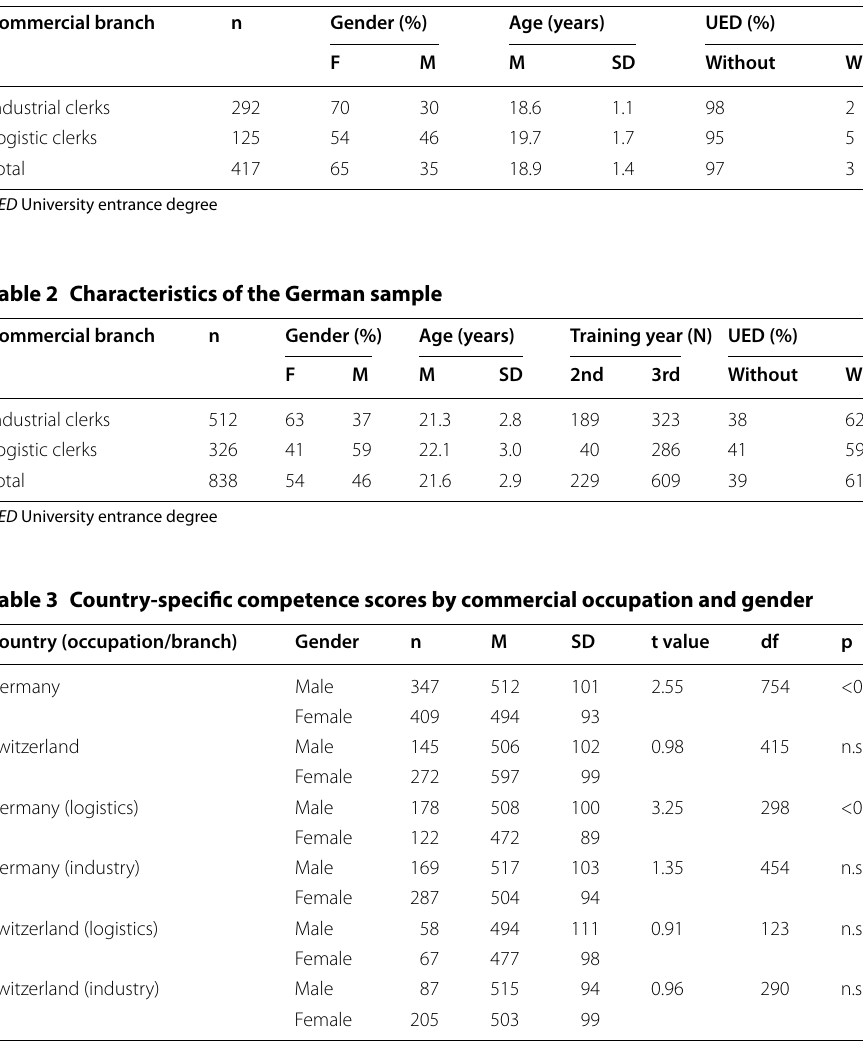
Table 1 Characteristics of the Swiss sample